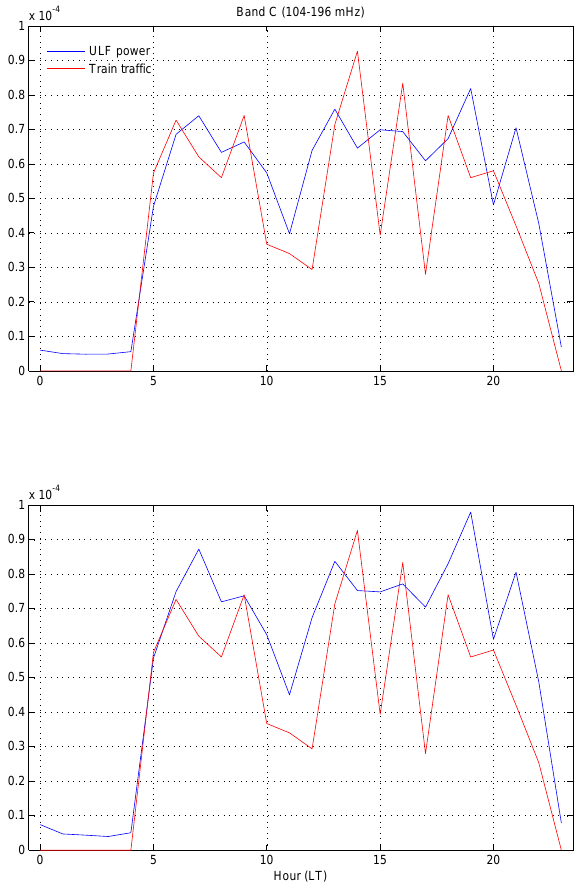
Figure 7. The trace of the estimated noise due to the train traffic (arbitrary scale) compared with the trace of the daily variation of the hourly-average power values for the entire week as evaluated for the whole period 2008–2010 (band C, in this example).